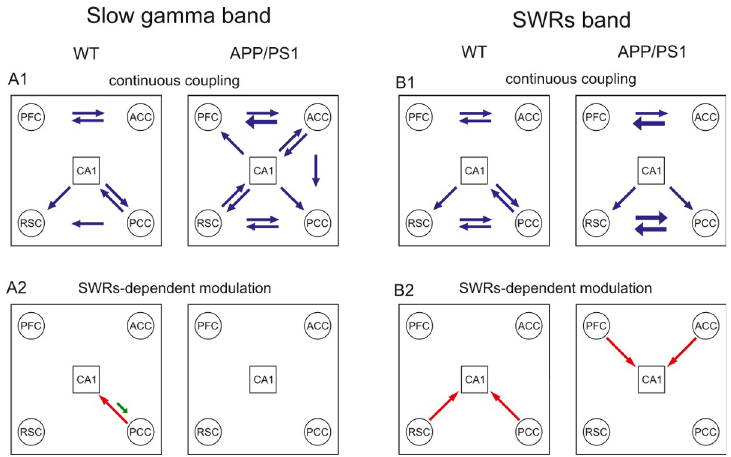
Fig 5. Comparison of effective coupling patterns in APP/PS1 and WT groups. The wiring diagram of effective connections between cortical areas and hippocampus (CA1) expressed in the slow gamma (A) and SWRs (B) frequency band is shown. Continuous coupling exceeding 35% of a maximal value of given frequency band are indicated by blue arrows. In the APP/PS1 group connections which significantly increased compared to the WT are indicated by thick blue arrows. A significant increase or decrease of the connectivity strength during the occurrence of SWRs is indicated by red and green arrow, respectively.